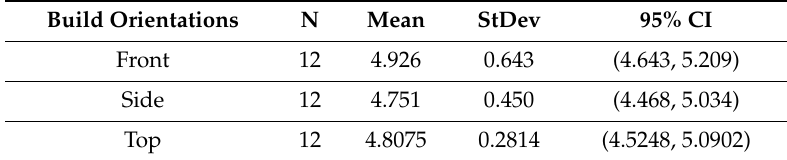
Table 25. Mean, standard deviation, and confidence interval for percentage elongation as a function of build orientations.